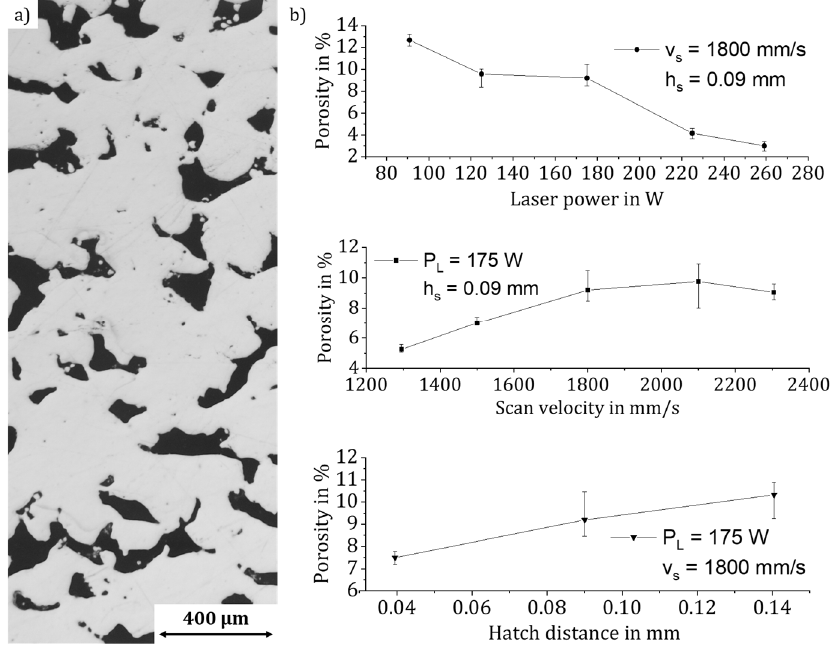
Figure 2. Influence of the main parameters P L , v s , h s on the formation of lack of fusion pores in the material AlSi10Mg: ( a ) microsection, ( b ) influence of the process parameters.